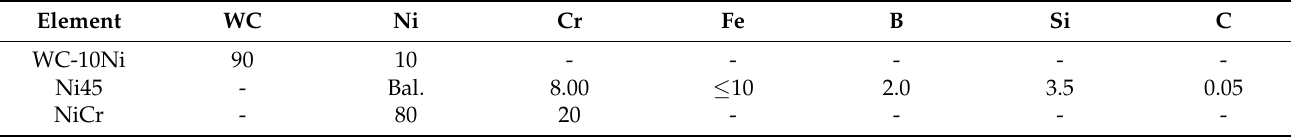
Table 1. Chemical composition of the powders (wt